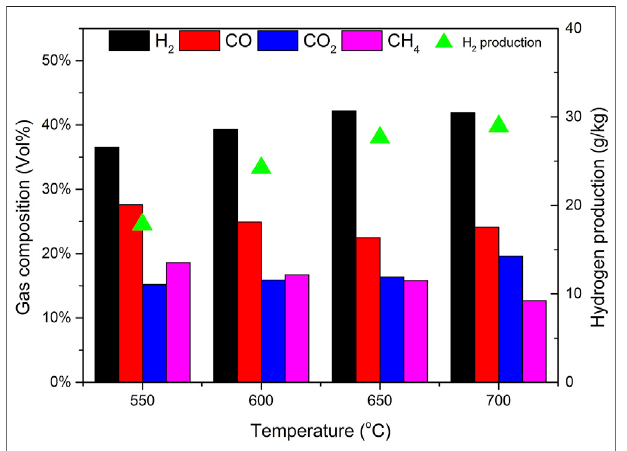
FIGURE 11 | Effect of temperature on gas composition and hydrogen production.